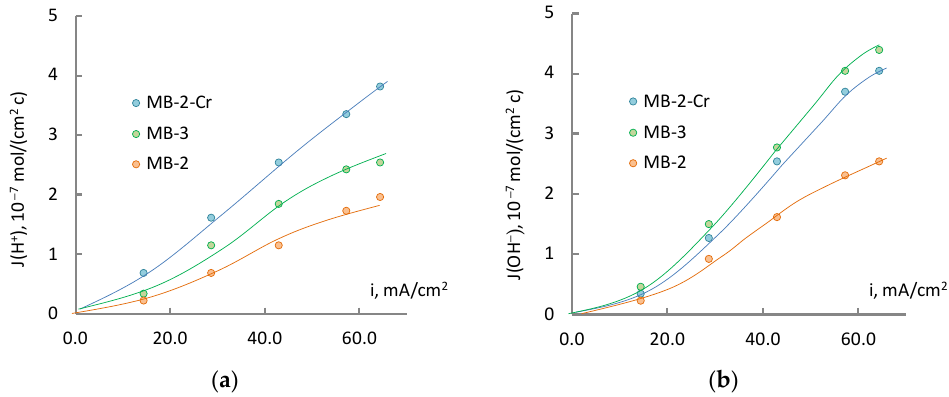
Figure 8. Flux density of hydrogen ( a ) and hydroxyl ( b ) ions as a function of current density during electrodialysis with bipolar membranes.